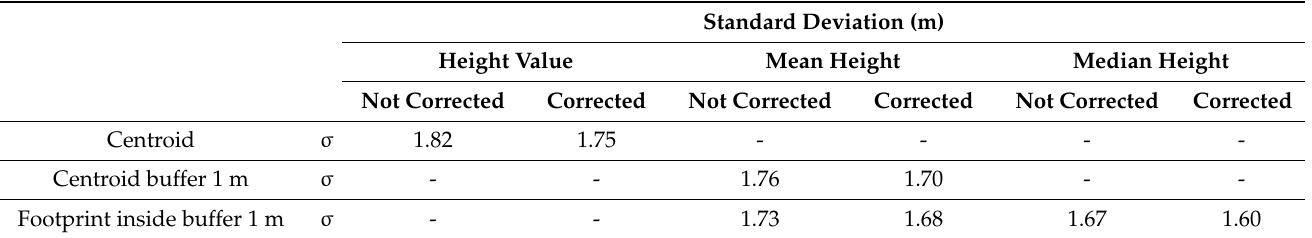
Table 8. Standard deviation obtained for the four tested approaches for deriving the building height: centroid, centroid with 1 m buffer and the footprint with an inside buffer of 1 m.